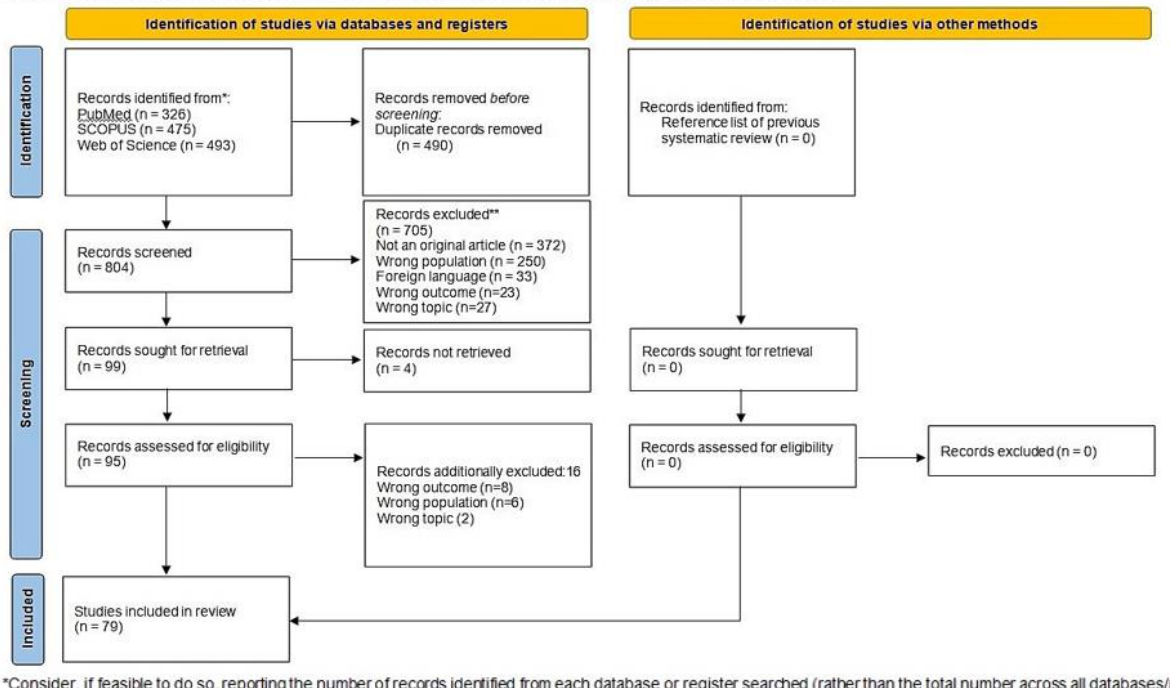
Figure 1. Flow diagram.